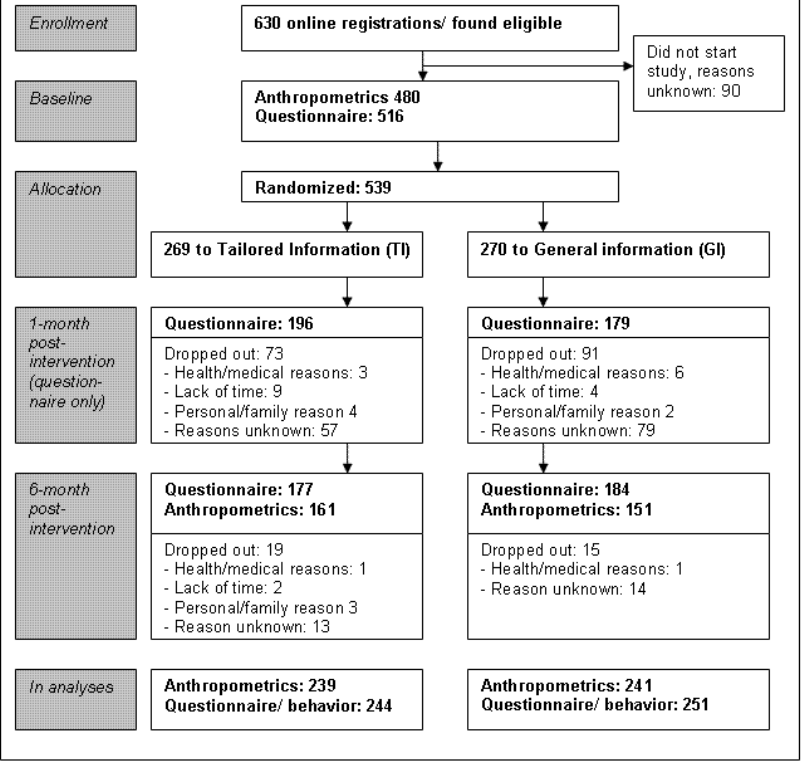
Table 2. Crude means and difference of objectively measured anthropometric outcomes at baseline and 6-month post-intervention (N=480).